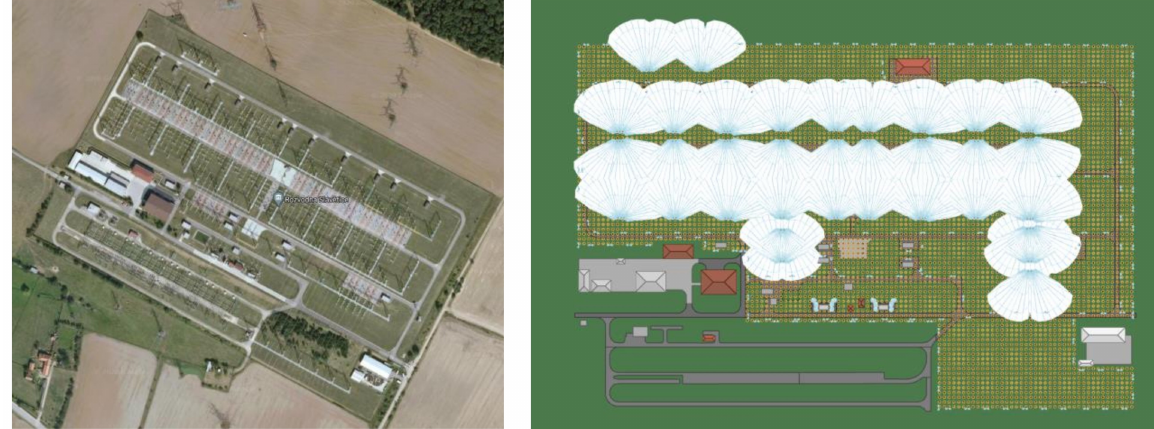
Figure 7. Layout of the electrical substation TR Slavˇetice, the area for modelling is